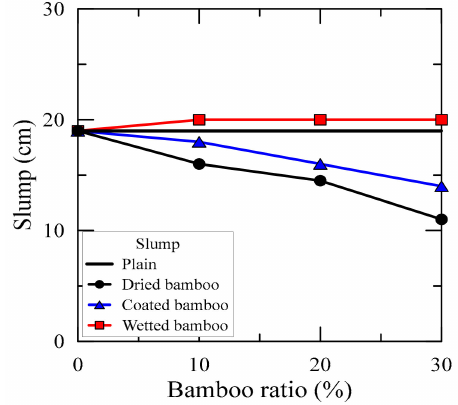
Figure 2. Results of slump tests.